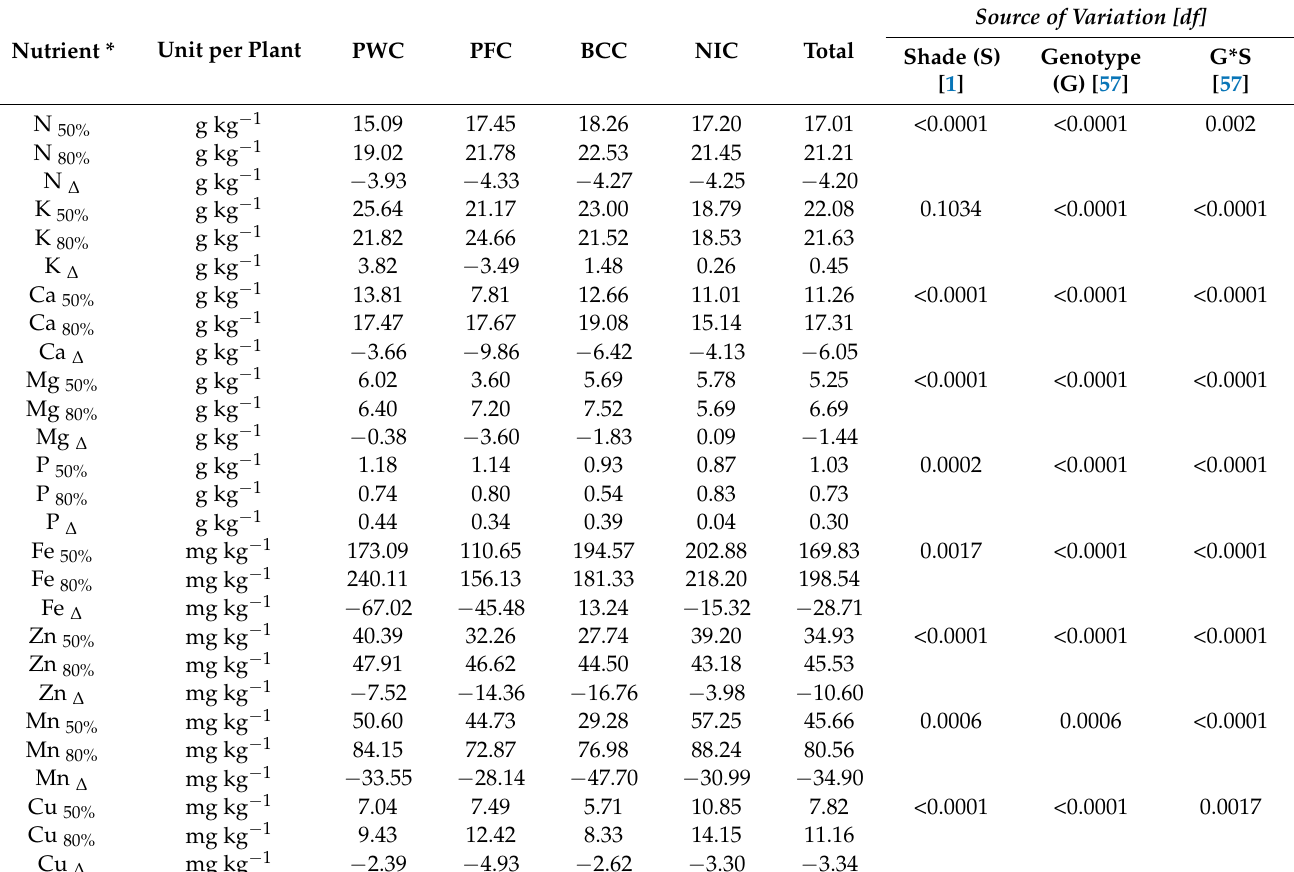
Table 4. Effect of shade on macro- and micronutrients concentration in 58 cacao genotypes from different origins subjected to 50% and 80%